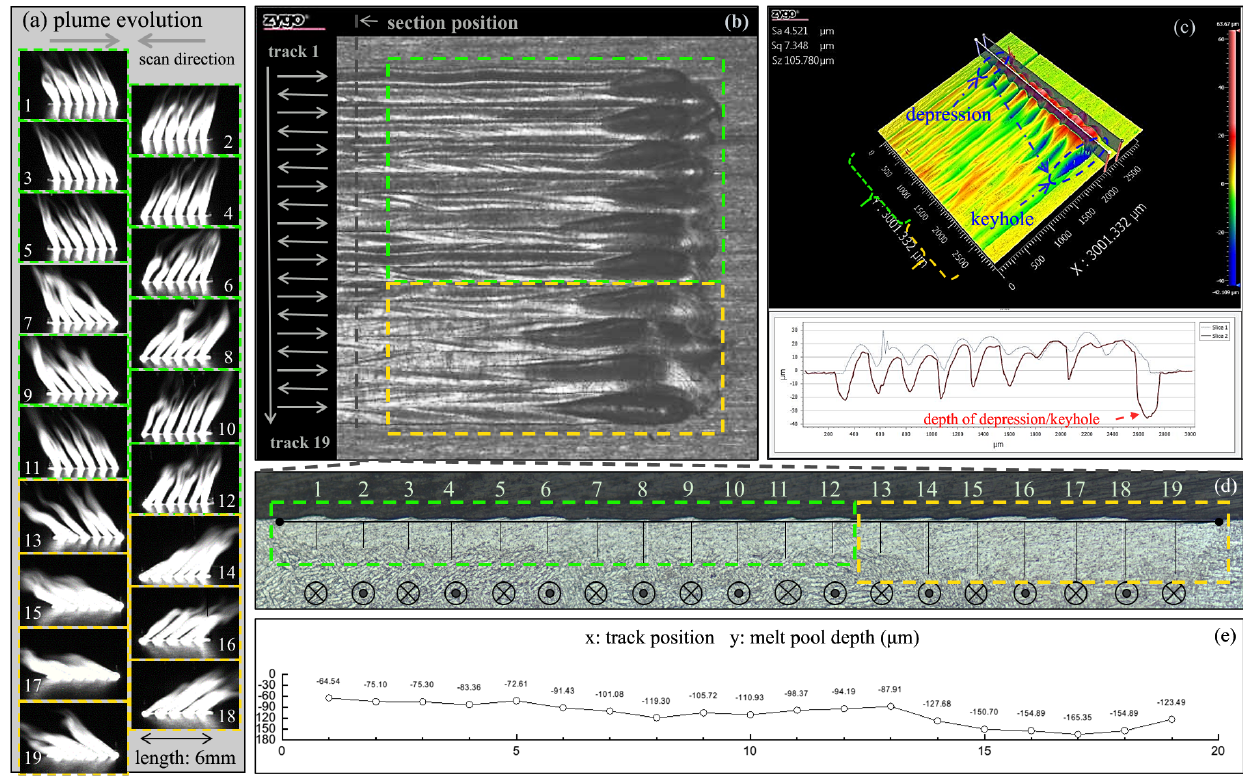
Figure 8. Correlation of plume behavior and melting quality in multi-track laser scanning at 400 W–800 mm/s. ( a ) Track- by-track superimposed images of plume evolution, the vertical plumes at the starting stages of each track are omitted for better clarity; the arrow indicates laser direction of the column and the track number are placed next to the track start. ( b ) Surface quality of the scanned layer. The gray arrows indicate scan direction and track succession, while the dashed line shows where the sample was sectioned. ( c ) 3D height map of surface roughness. ( d ) Cross section evolution and ( e ) penetration